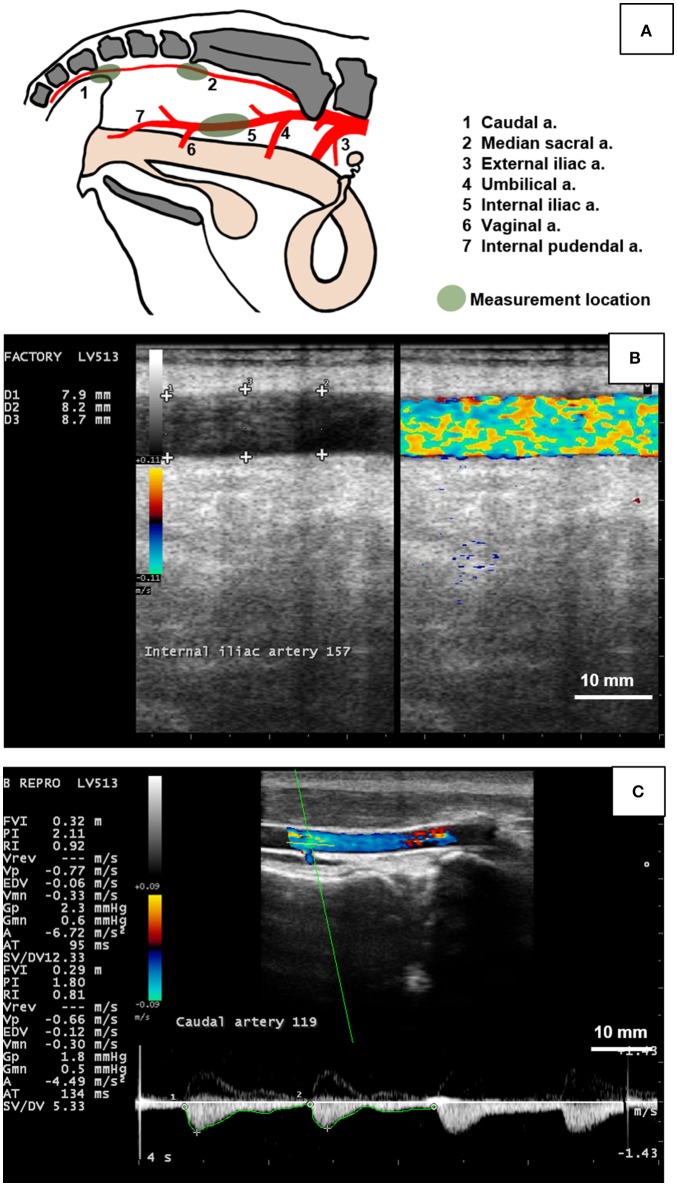
Measurement of the hemodynamic endpoints using B-mode and color Doppler ultrasonography of the caudal, median sacral, and internal iliac arteries in cows. (A) Diagram indicating branching pattern of major arteries (1 to 7) in the pelvic cavity and arterial measurement locations (green shaded areas). The caudal artery (1) was imaged transcutaneously at the fourth caudal vertebra. The median sacral artery (2) was imaged transrectally caudal to the sacral ridge at the highest point. The internal iliac artery (5) was measured transrectally between the umbilical (4) and vaginal (6) branches. (B) Duplex B-mode and Color Flow Doppler mode of the bovine internal iliac artery in longitudinal section was used to measure arterial diameter at 3 locations (+ signs) to obtain a single (average value) for each artery per day. (C) Doppler spectrum waveform (bottom part of image) of the bovine caudal artery was recorded by placing the sampling gate (horizontal and oblique green lines in artery lumen) and used to manually trace the waveform (green line along the bottom of the waveform) to obtain hemodynamic parameters including mean arterial velocity (MnV), peak systolic velocity (PSV), end diastolic velocity (EDV), pulsatility index (PI), and resistivity index (RI). Figure (A) was drawn based on Nickel et al. (40). Scale bar for Figures (B,C) = 10 mm.